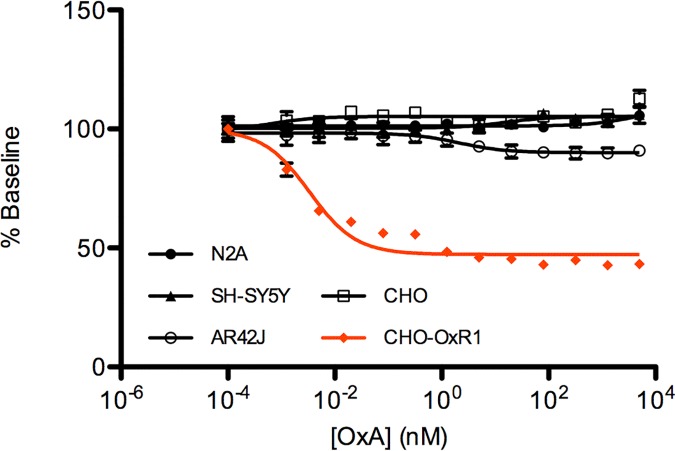
Characterization of cell lines previously reported to express orexin receptors.Each cell line was assayed for the presence of functional orexin receptors via the IP-One HTRF Assay. Cells were incubated with orexin A at various concentrations for 45 min. A CHO-based cell line stably expressing OX1 (CHO-OX1) was used as a positive control. The data are presented as a percentage of the baseline HTRF ratio (A665/A620 x 10000). Data points are mean (n = 3) and error bars represent standard error of the mean (SEM).